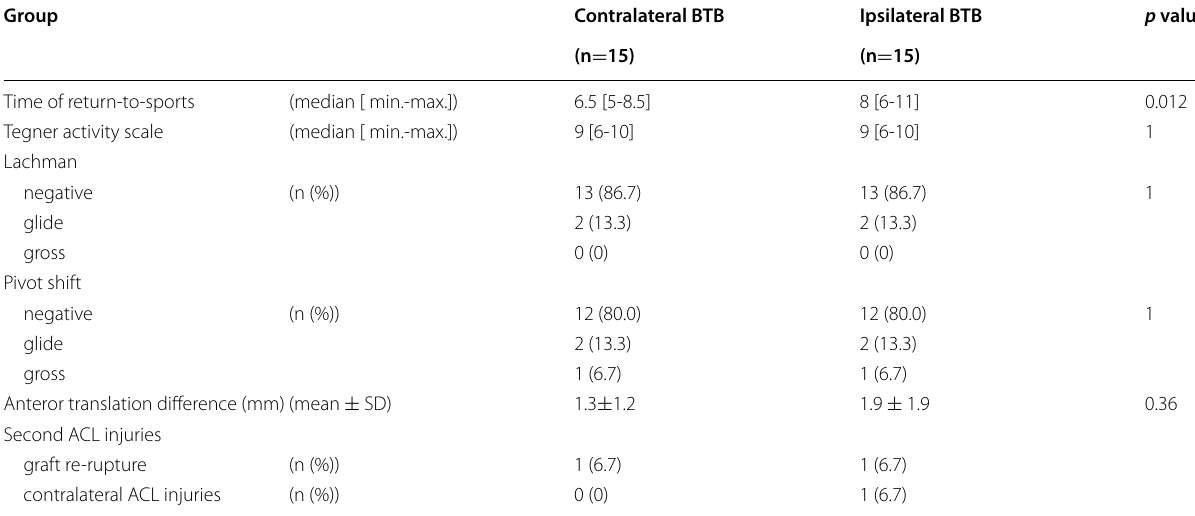
BTB Bone-tendon-bone